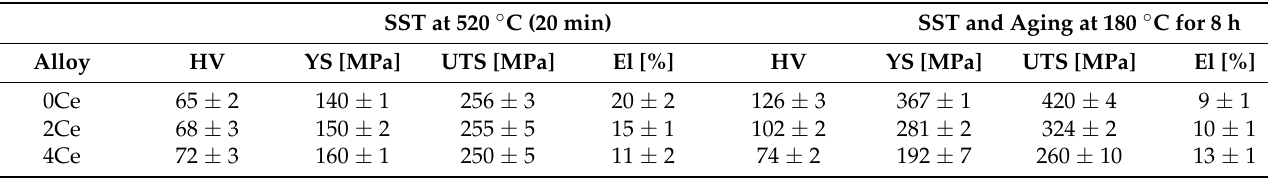
Table 4. Mechanical properties of the thermomechanical-treated samples after solid solution treatment and artificial aging (standard deviation are presented as an error bar). SST at 520 ◦ C (20 min) SST and Aging at 180 ◦ C for 8